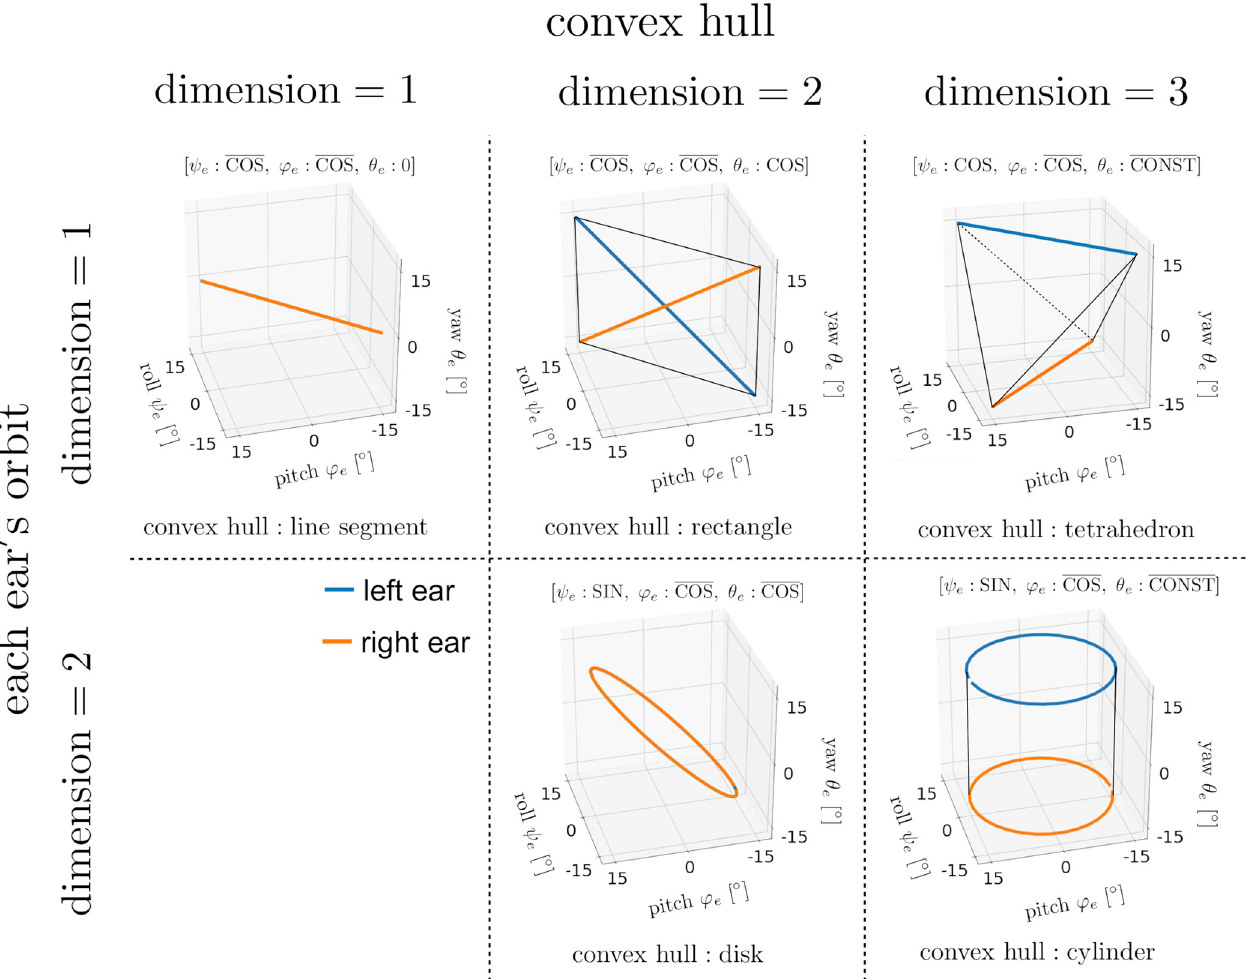
Fig 7. Five types of dimension pairs of the convex hull and each ear’s orbit. The blue lines indicate the left ear’s orbit ð c l indicate the right ear’s orbit ð c r is displayed in each